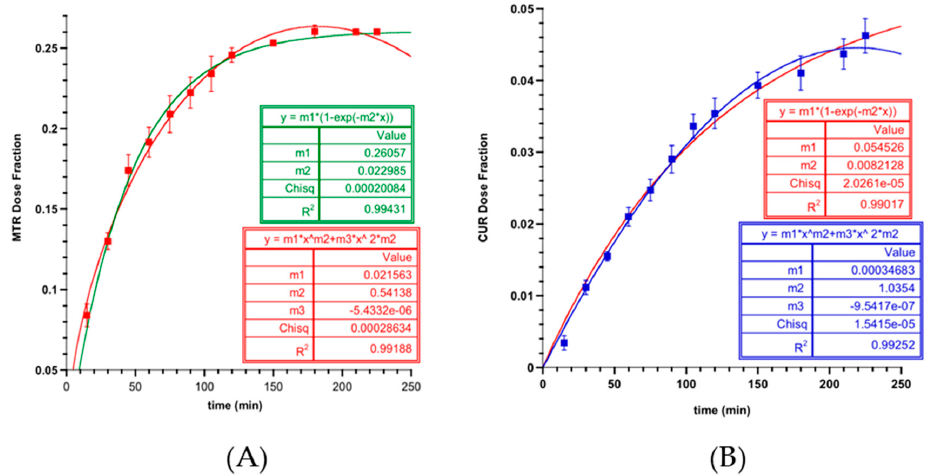
Figure 8. Timeline from 0 to 120 min of radial and frontal swelling of the minitablet.